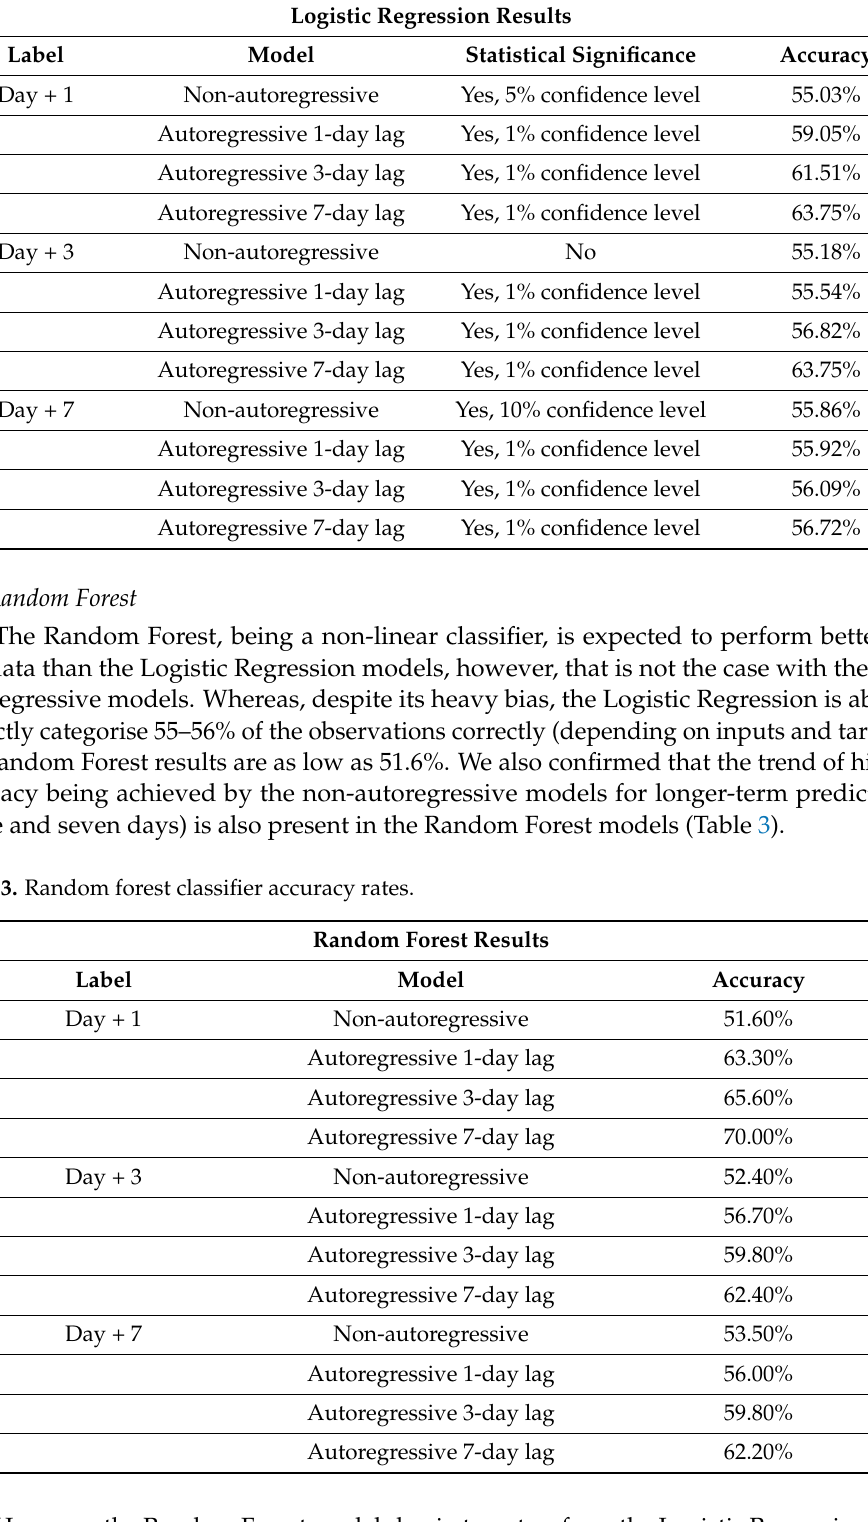
Table 2. Full results from logistic regression experiments.